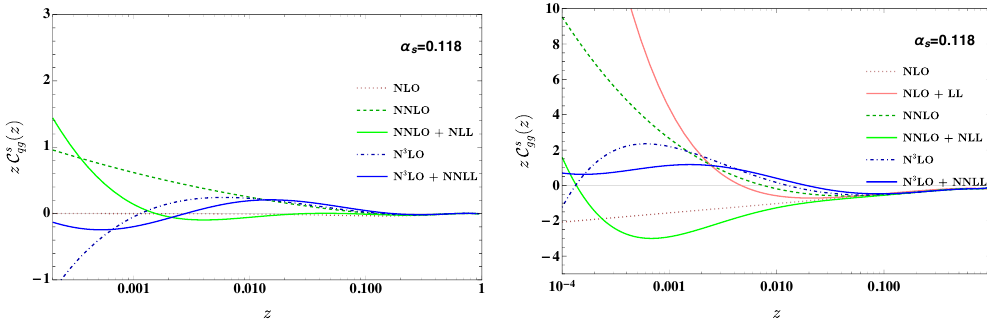
Figure 2 . Coefficient functions for gluon TMD FFs. Shown in the plots are fixed-order results at NLO, NNLO and N 3 LO, as well as adding the higher-order resummation contributions truncated to order α 15 s